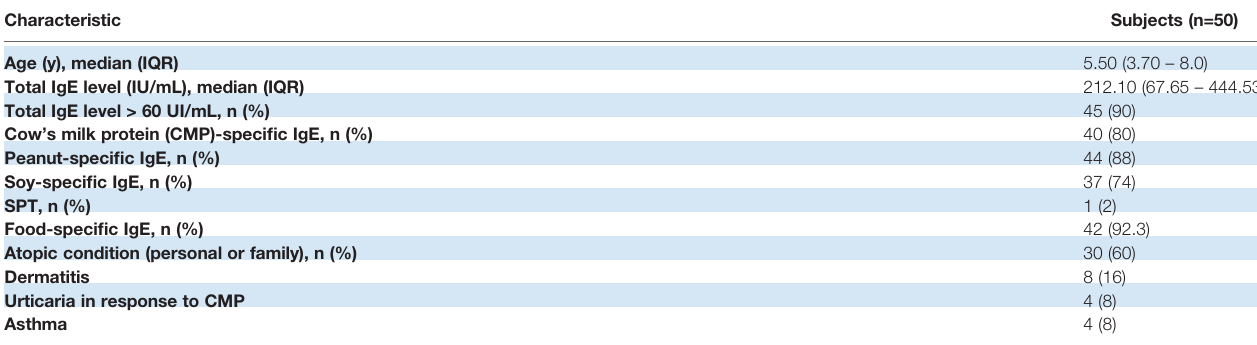
TABLE 2 | Demographics of pediatric patients with rectal bleeding and juvenile polyps.